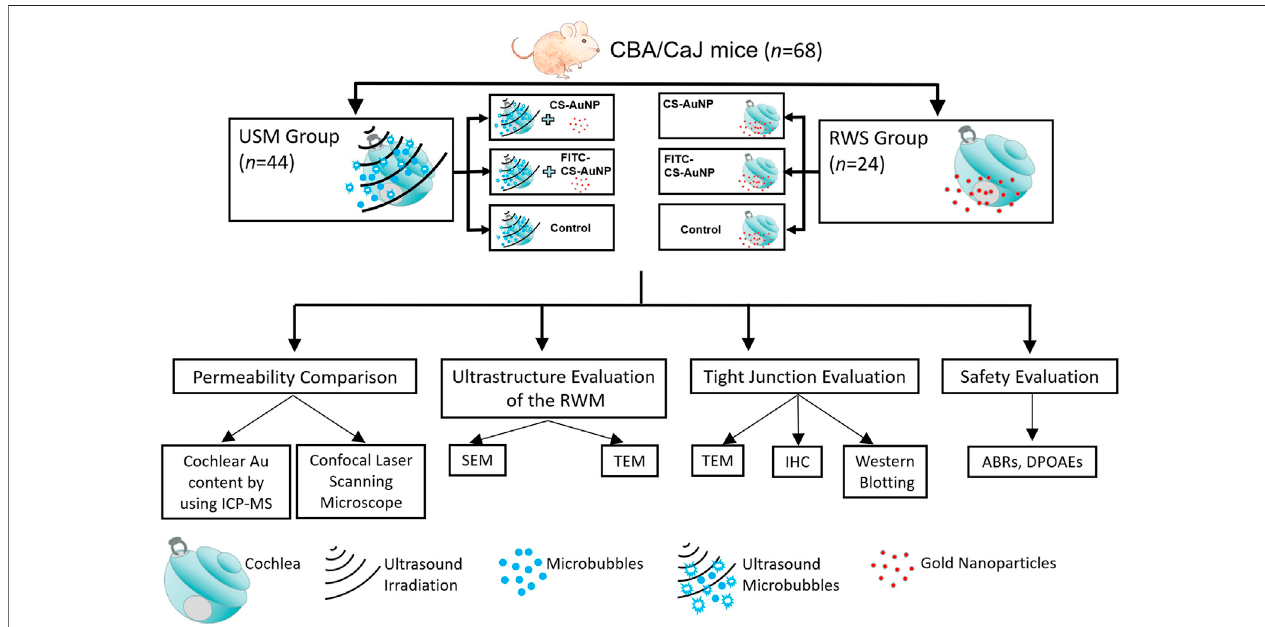
FIGURE 1 | Schematic of this study. USM, ultrasound microbubble treatment; RWS, round window membrane soaking treatment; RWM, round window membrane; CS-AuNP, chitosan-coated gold nanoparticle; FITC, fl uorescein thiocyanate; ICP-MS, inductively coupled plasma mass spectrometry; SEM, scanning electron microscopy; TEM, transmission electron microscopy; IHC, immunohistochemistry; ABRs, auditory brainstem responses; DPOAEs, distortion-product otoacoustic emissions.